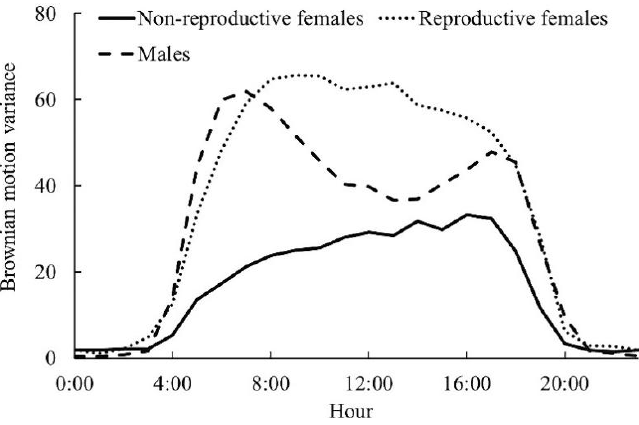
Figure 1. Diel movement patterns of Reeves’s Pheasants during the breeding season.